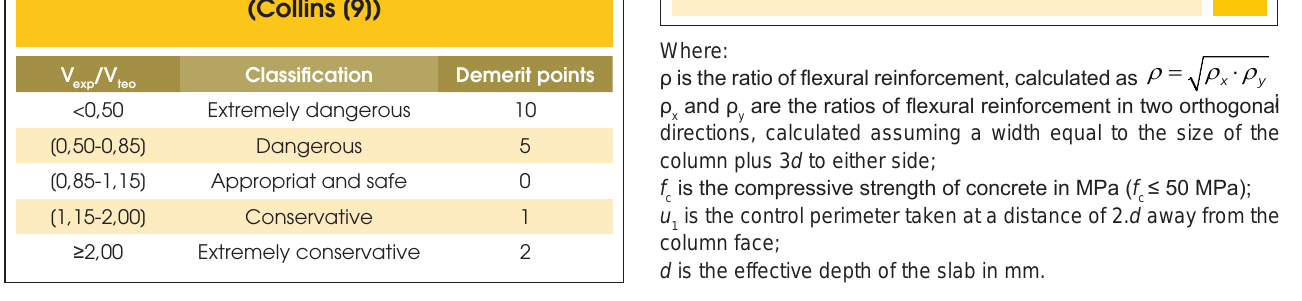
Table 1 – Classification by demerit